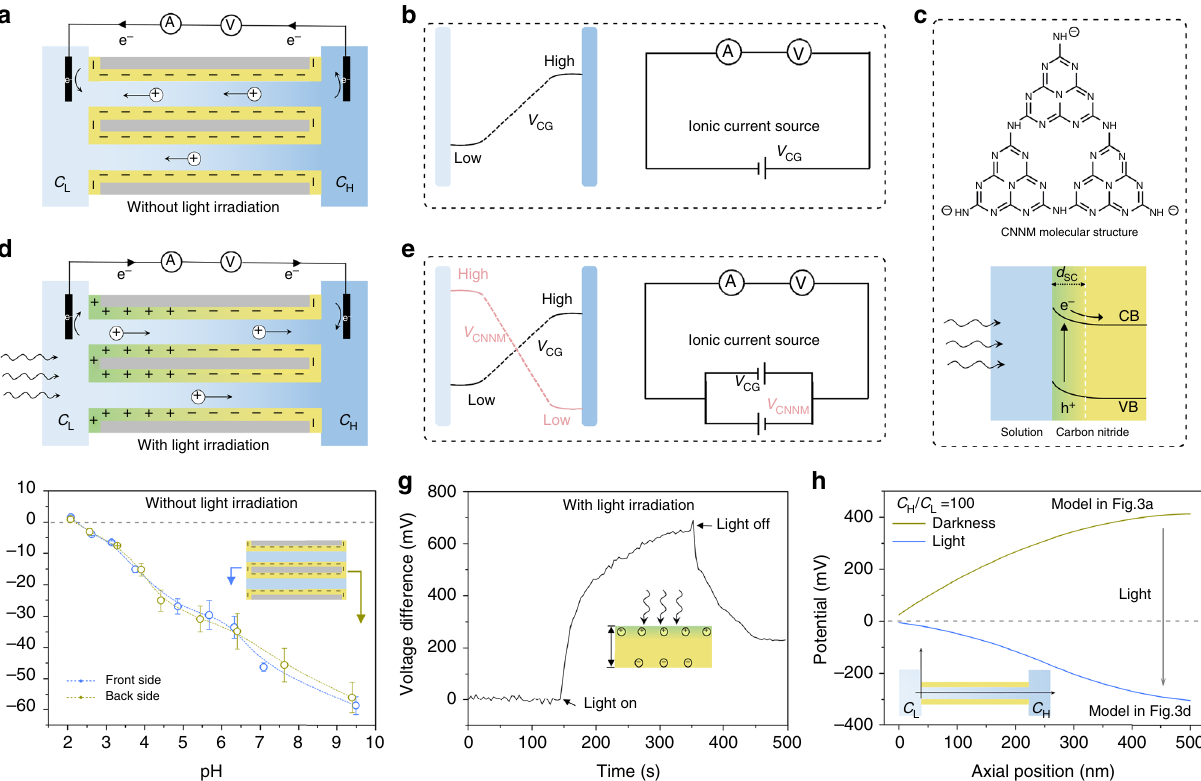
Fig. 3 Origin of ion pump phenomenon. a Schematic of surface charge distribution on the nanotube before illumination, in which condition low-density negative charge is homogeneously distributed on the nanotube. b Equivalent circuit of a , the concentration gradient potential ( V CG ) is the only ionic current source. c Negative charged molecular structure and photo-induced separation of electrons and holes of carbon nitride. d Schematic of surface charge distribution on the nanotube after illumination, in which condition the separation of electrons and holes results in the heterogeneous charge distribution. e Equivalent circuit of d , transmembrane potential ( V CNNM ) provides a contrary potential with V CG . f Zeta-potential of the CNNM shows the negative charged surface before illumination. g The voltage difference between illuminated and non-illuminated sides shows transmembrane potential. Error bars represent standard deviations of three independent experiments. h The calculated electrical potential pro fi le along the axis of the nanotube when integrating 100-fold concentration gradient based on the two models illustrated in a and d , which are based on the 500-nm-long nanotube with 30-nm- diameter. The potential of low concentration side ( C L ) is preset as 0